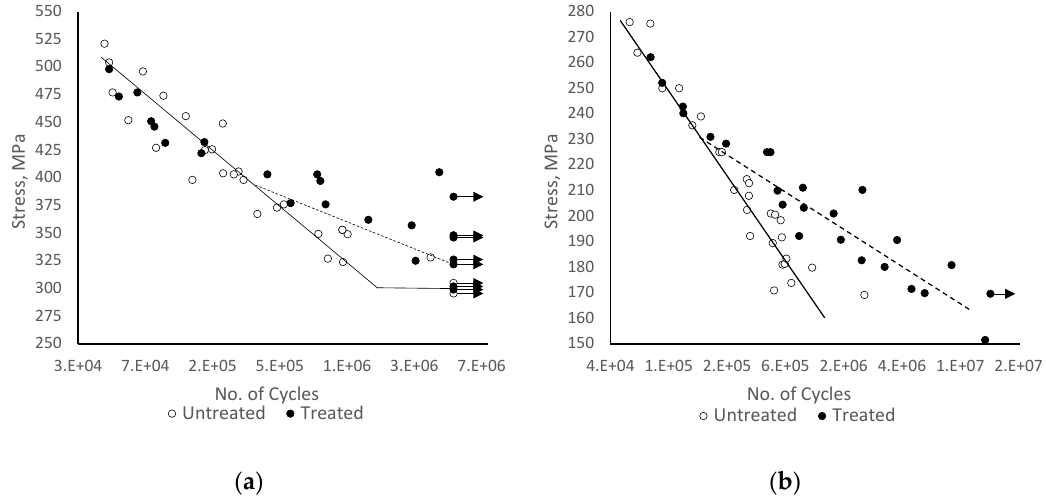
Figure 2. S–N curves for untreated and treated EN8 Steel ( a ) and AA2014-T6 ( b ); data for samples where the test was stopped without sample fracture are marked as •→ .